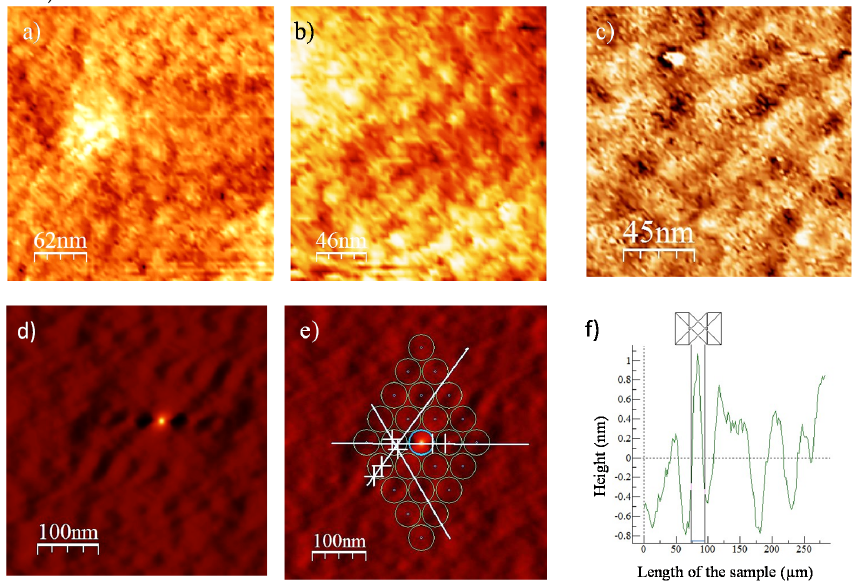
Figure 5. AFM images of mesoporous Li 4 Ti 5 O 12 thin films calcined at different temperatures: ( a ) 350 °C, ( b ) 550 °C, ( c ) 700 °C; ( d ) and ( e ) 2D FFT analysis of porosity in 700 °C thin-films in the three directions of cubic arrangement, and ( f ) section graphs in one of the selected direction marked in image ( e ).